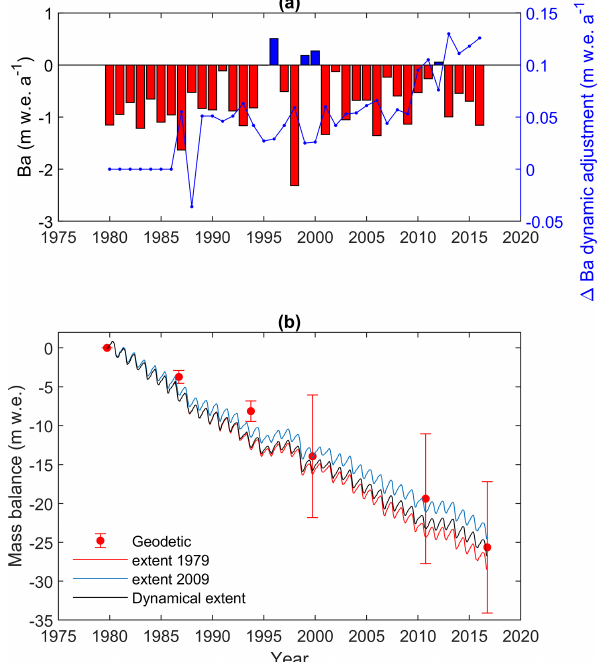
Figure 7. Simulated mass balance compared with geodetic esti- mates. (a) Conventional annual glacier-wide mass balance ( B a from the dynamical simulation (multitemporal DEMs). The blue curve represents the effect of dynamical adjustment on B a mulative mass balance from reference (red: 1979, blue: 2010) and conventional (black: multitemporal DEM) simulations. Error bars represent 1 σ cumulative confidence intervals around the cumulative geodetic mass balance.